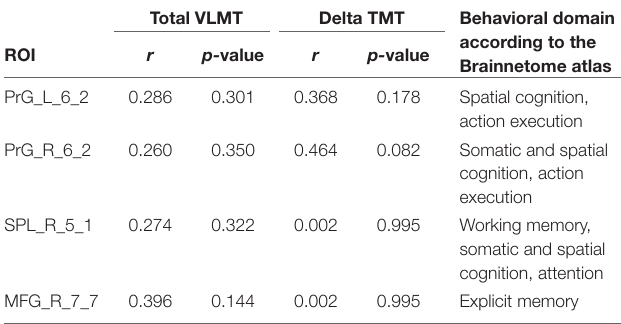
TABLE 4 | Correlation between DC of cognition-related compensatory ROIs, total VLMT, and delta TMT scores in senior HC. Total VLMT Delta TMT Behavioral domain atlasROI